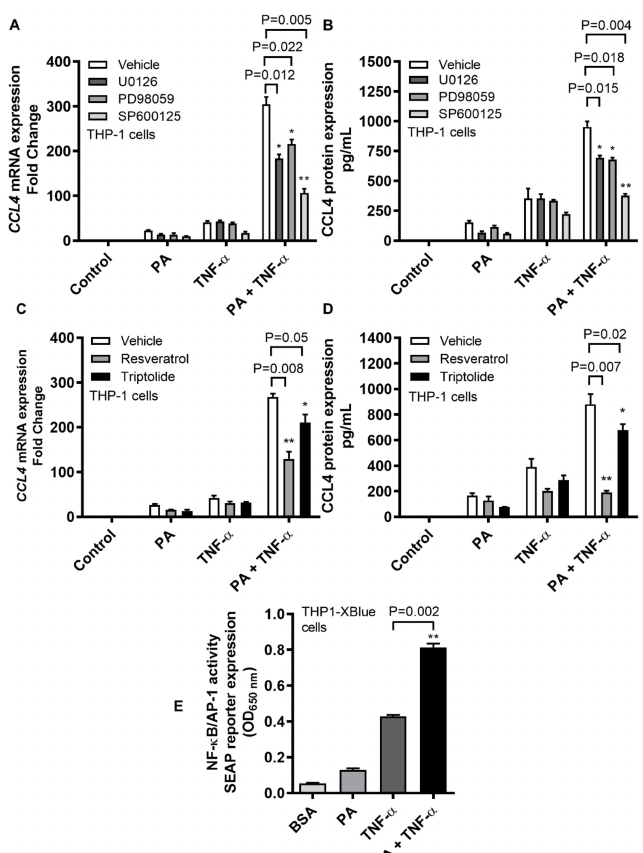
Figure 5. CCL4 co-induction by TNF- α / palmitate involves the MAPK / NF- κ B signaling pathways. To see whether the TLR4 downstream signaling involved MAPK / NF- κ B pathways, THP-1 cells were pre-treated with specific pathway inhibitors before co-stimulation with TNF- α / palmitate as described in the materials and methods section. ( A ) The data (mean ± SEM) show that following TNF- α / palmitate co-stimulation, CCL4 mRNA expression was significantly suppressed in cells that were treated with MAPK inhibitors including U0126 ( p = 0.012), PD98059 ( p = 0.022) and SP600125 ( p = 0.005) compared to the control (mock). ( B ) As expected, CCL4 protein expression following TNF- α / palmitate co-simulation was also abrogated in cells that were treated with U0126 ( p = 0.015), PD98059 ( p = 0.018) and SP600125 ( p = 0.004) as compared to the control. Likewise, NF- κ B-mediated signaling was intercepted by using specific pathway inhibitors including resveratrol and triptolide. ( C ) The data (mean ± SEM) indicate that CCL4 mRNA expression was significantly downmodulated in THP-1 monocytic cells that were treated with resveratrol ( p = 0.008) and triptolide ( p = 0.05) compared to the control (mock). ( D ) Similarly, CCL4 secreted protein was also reduced in cells that were treated with resveratrol ( p = 0.007) and triptolide ( p = 0.02) compared to control. ( E ) To further confirm that TNF- α / palmitate co-stimulation induced the NF- κ B / AP-1 activity, THP1-XBlue cells expressing the NF- κ B / AP-1 promoter linked to the SEAP reporter were used. The data (mean ± SEM) show that co-stimulation with TNF- α / palmitate induced a stronger NF- κ B / AP-1 activity as compared to stimulation with TNF- α alone ( p = 0.002). * Significant ( p < 0.05), ** Very significant ( p <